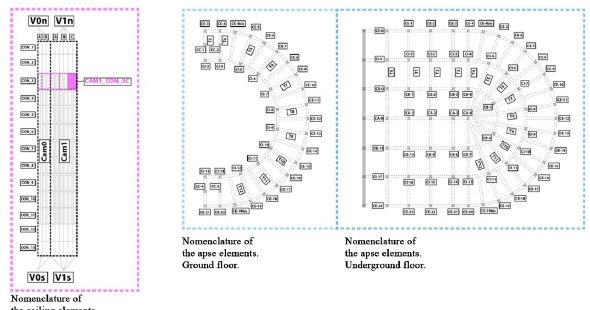
Figure 1 . Classification and nomenclature scheme of the modular elements composing the Hall